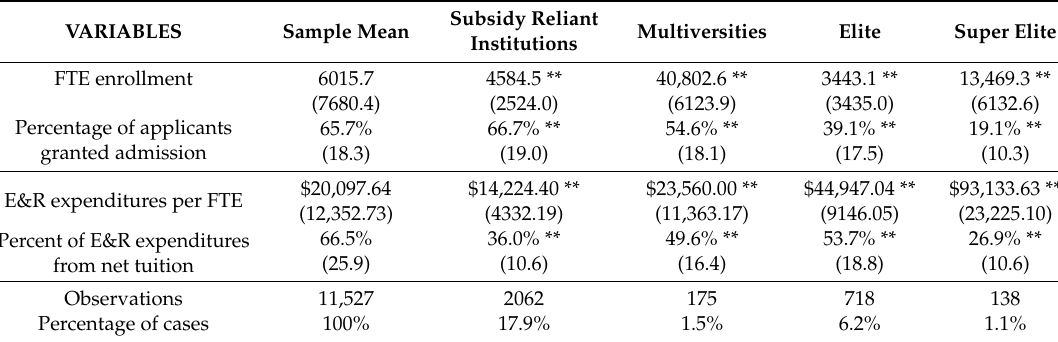
Table 1. Profiles offering good value seats.